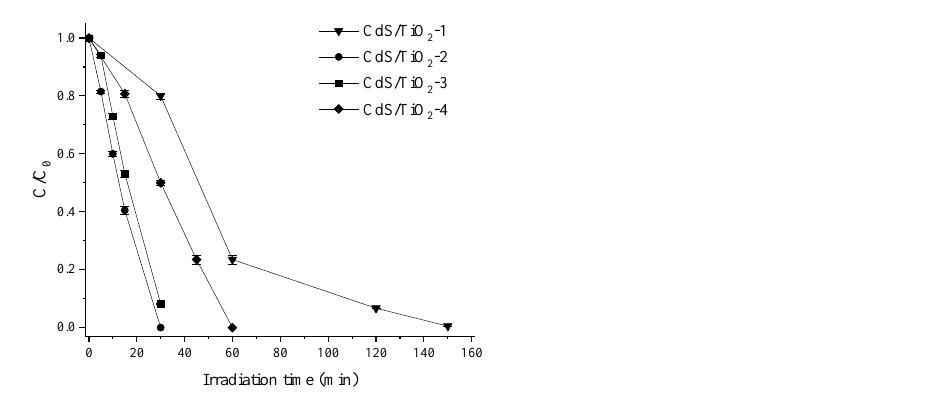
Figure 8. C/C 0 ratio vs. time profiles obtained upon irradiation ( λ ≥ 420 nm, 25 ◦ C) of CdS/TiO 2 -(1–4) (3 g/L) suspended in a deaerated CH 3 CN/2-PrOH (4/1) reaction mixture containing a starting NBA concentration of 1 × 10 −4 M.